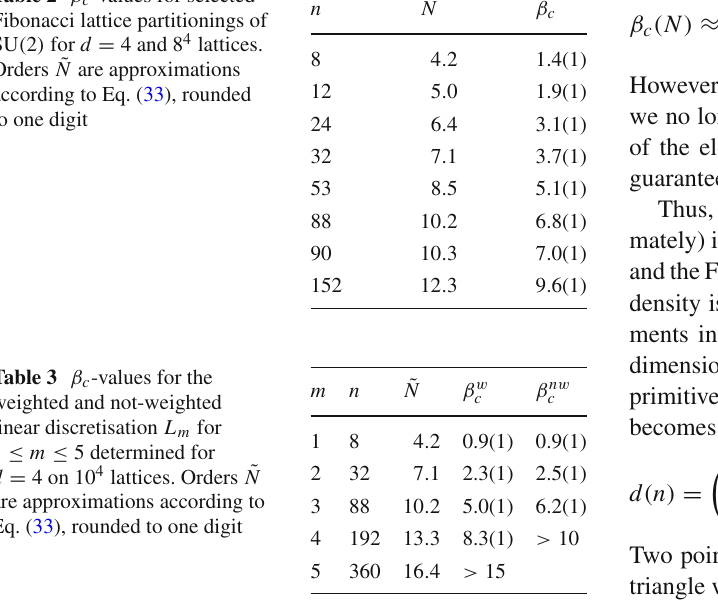
Table 2 β c -values for selected Fibonacci lattice partitionings of SU ( 2 ) for d = 4 and 8 4 lattices. Orders ˜ N are approximations according to Eq. (33), rounded to one digit